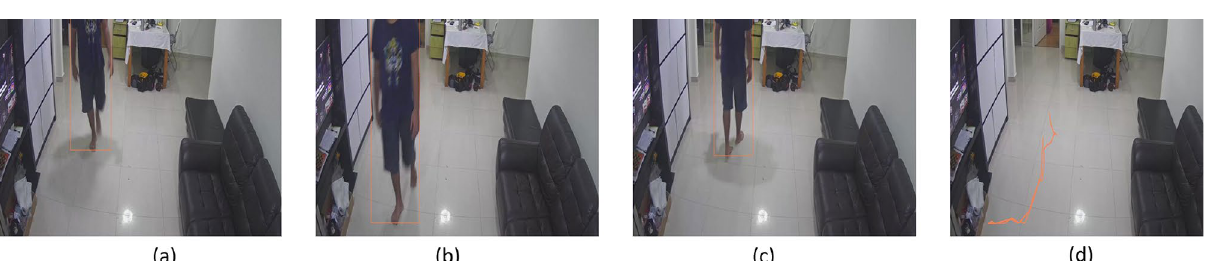
Figure 5. Real-time detection of stain, foot stain, trash.